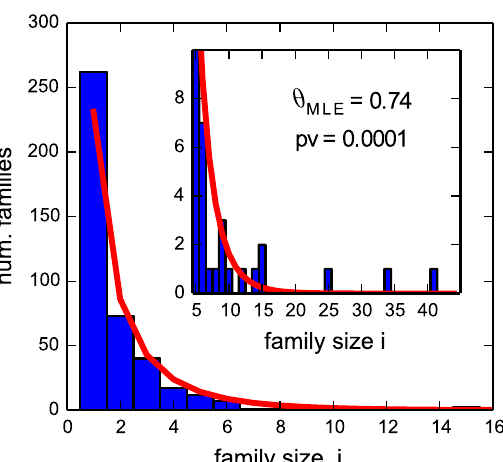
Figure 2. Size distribution of motif families in human. The distribution accounts for 906 human TFs, organized in 424 families whose members share at least one PWM with at least another member. The inset is a zoom on the range of sizes > 5. The red-line is the best-fit model according to maximum likelihood estimation, which has a goodness-of-fit p-value p < 0.0001. The model captures the general trend, but clearly underestimates the number of families of size 1 and does not predict the presence of the largest